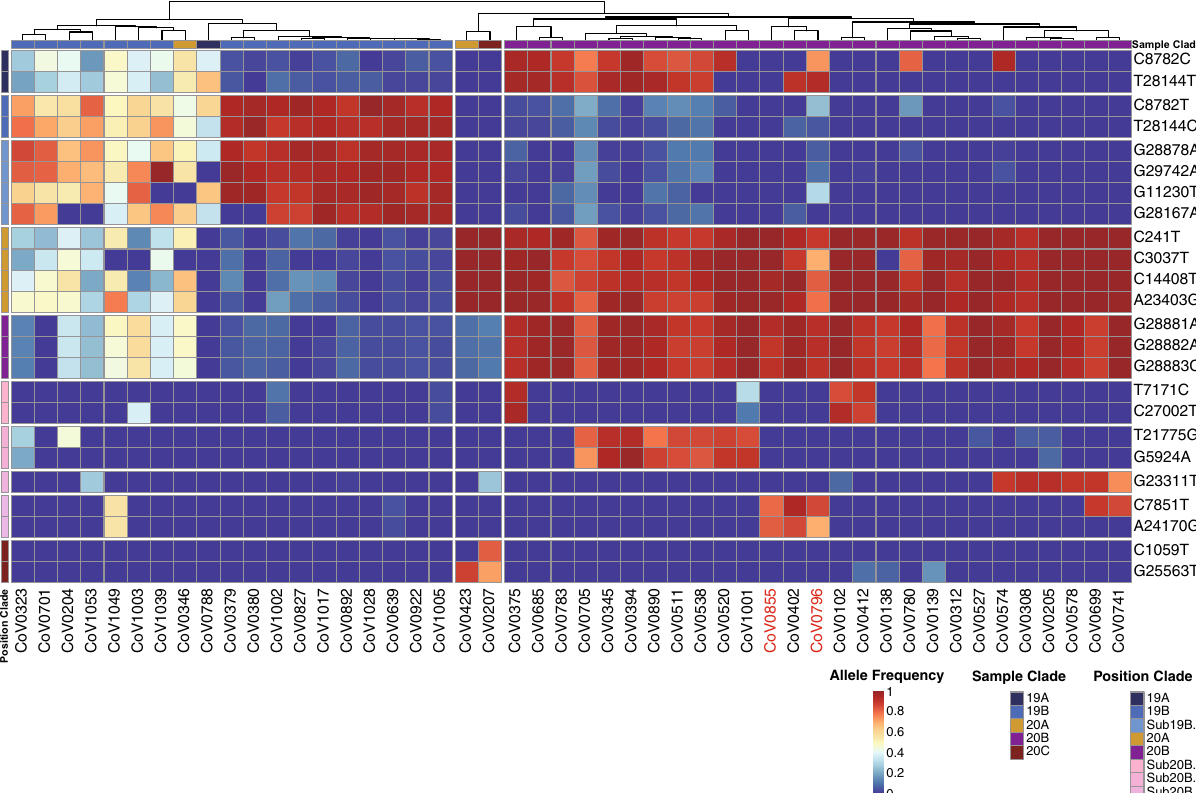
Figure 5. Co-infection with multiple SARS-CoV-2 variants. Evidence for human-to-human transmission of multiple SARS-CoV-2 variants were established using the clade and sub-clade definitive viral genetic variants. Columns display the de-identified sample ID that carried more than one SARS-CoV-2 viral variants in the nasopharyngeal swab sampling (N = 48). Color bar shows the viral clade assigned to the individual, according to the consensus viral sequence, reflecting the dominant clade in one sample. Rows indicate the eleven clade- definitive and eleven sub-clade definitive variants. Heatmap color, ranging from red to blue, suggests the allelic proportion of the derived allele of the iSNV. The ID of two longitudinal samples were marked in